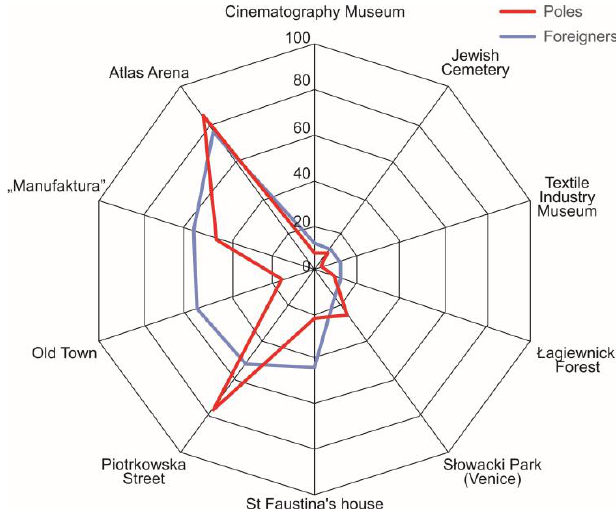
Figure 6. Lodz attractions visited by respondents (Source: authors, based on a